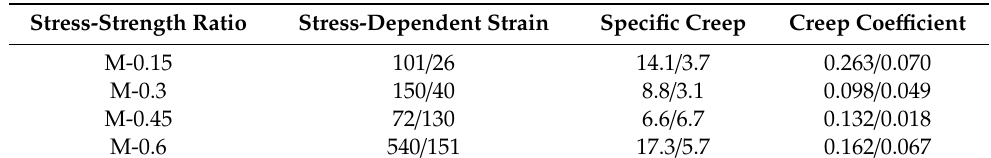
Table 8. The average and standard deviation of residual values by improved model predicted value minus experimental data value (shown as average / standard deviation).